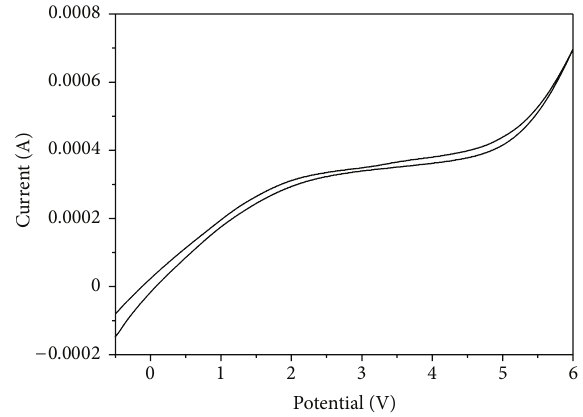
Figure 2: Cyclic voltammograms of a 2.0 mol/L NaNO 3 blank solution in a thin-cell reactor based on the TNA electrodes under illuminations of 7.9mW/cm 2